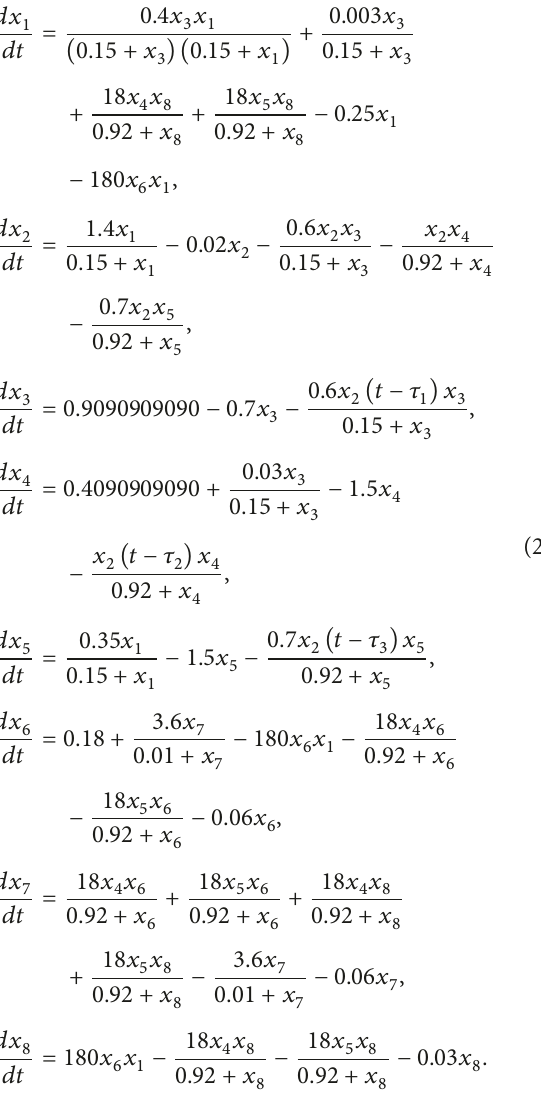
= 1.2, 𝑥 1 = 0, 𝑥 = 0 , and 𝑆 = 5, 𝑘 7 8